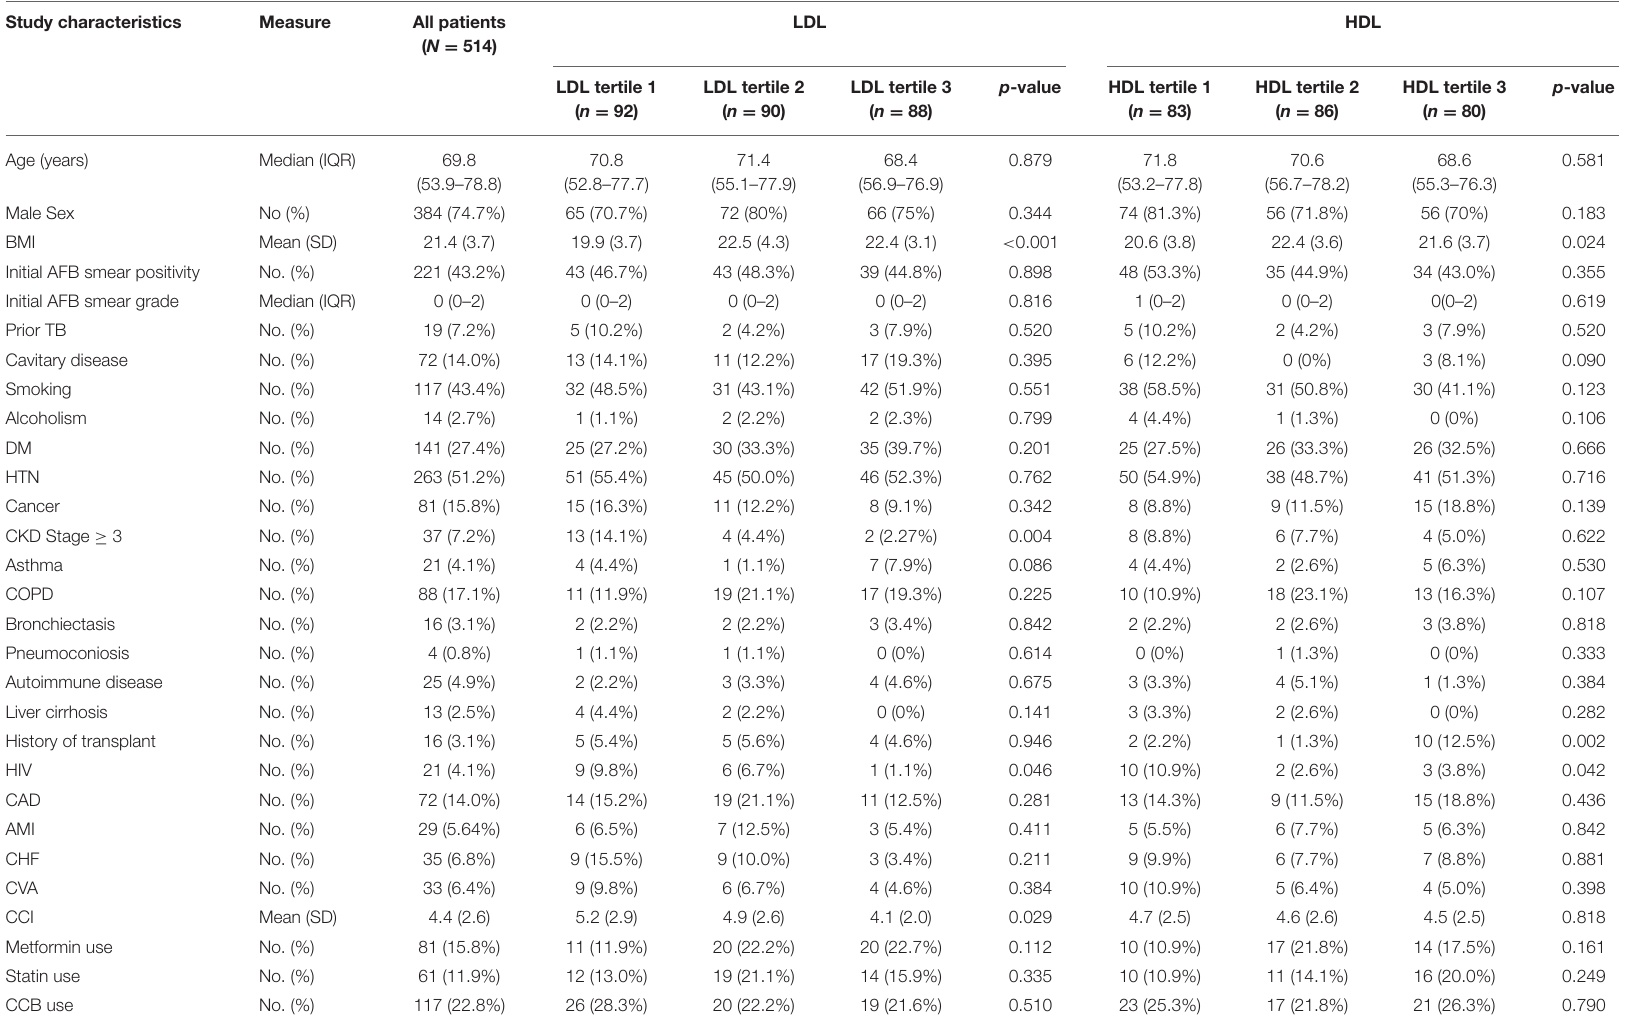
TABLE 1 | Patient characteristics based on tertiles of baseline LDL and HDL